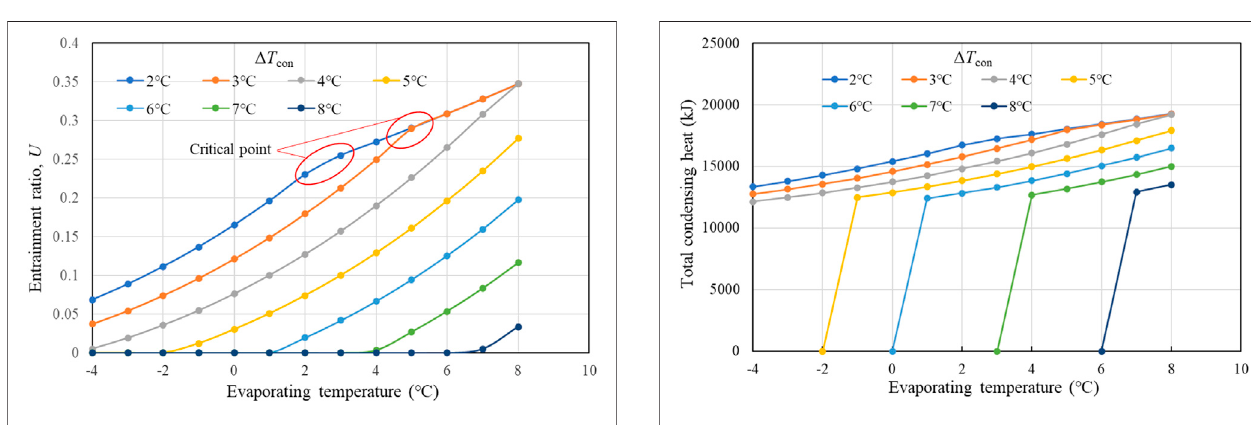
FIGURE 10 | Effects of evaporating temperature on the entrainment ratio.